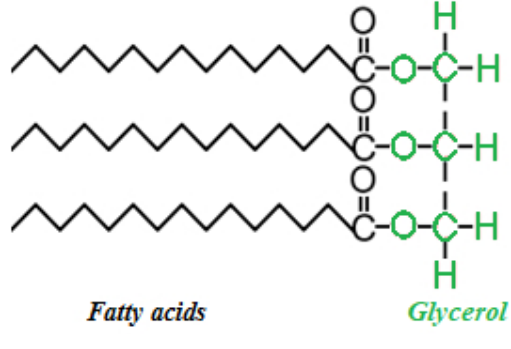
Figure 4. Triglyceride [37].